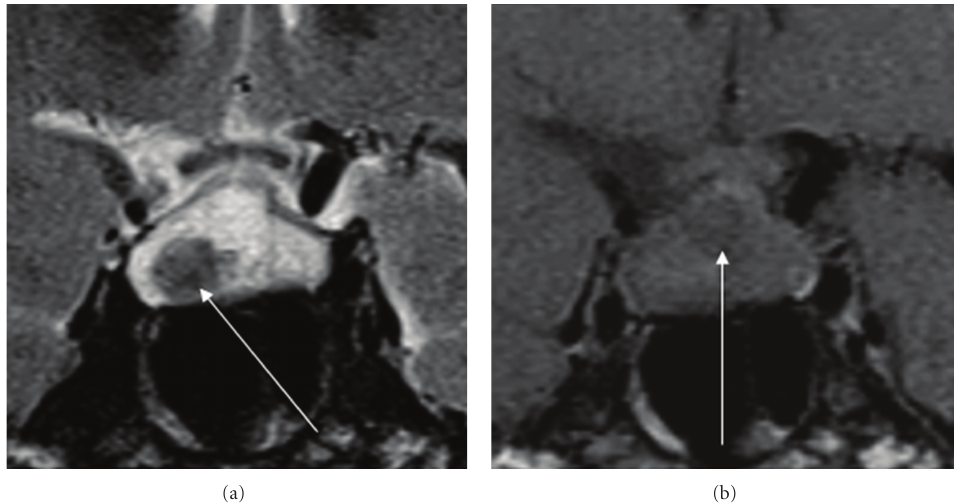
Figure 3: Case 17: nonenhanced coronal MRI images of RCC. (a) T2-weighted image: nodule with hypointense signal at right lower part (arrow). (b) T1-weighted image: nodule with hypointense signal at the upper part